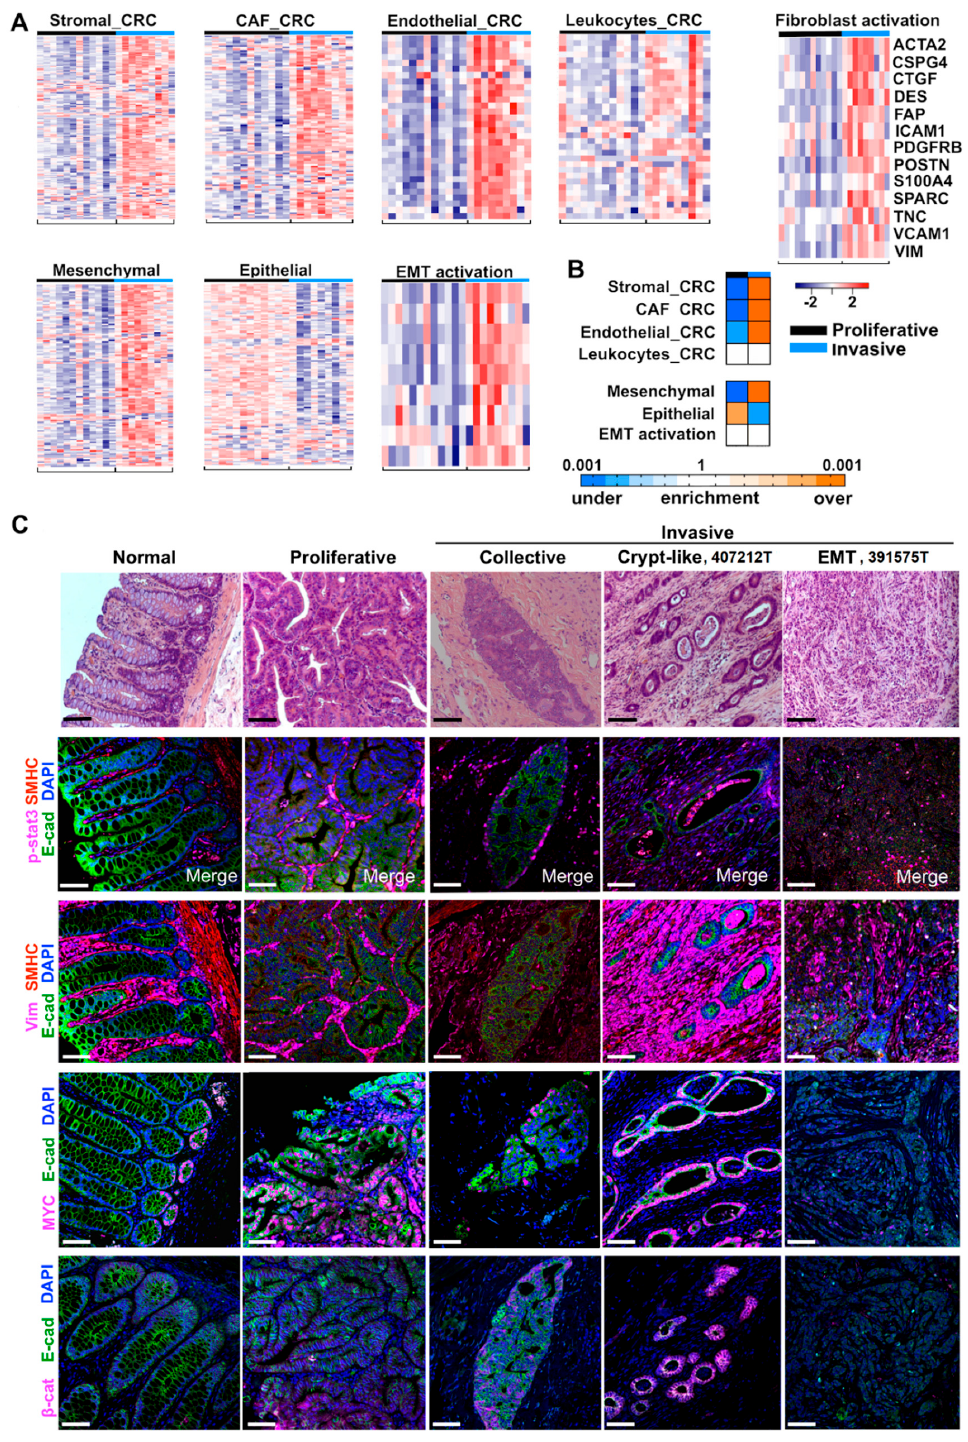
Figure 3. Stromal signatures are activated in invasive tumors and three invasion modes are observed. ( A ) Heatmaps indicate higher expression levels of stromal and EMT signature genes in invasive tumors than in proliferative tumors. Heatmaps are presented as described for Figure 2A. ( B ) Heatmaps of the GSEA p-values of the signatures indicated. ( C ) Representative IHC images of normal colon, proliferative tumor, and tumors of three invasion modes. In crypt-like invasion (407212T), tracks of MYC-positive crypt-like structures are surrounded by dense and multilayers of fibroblasts. β -cat: β -catenin. See also Figure S3, Tables S2 and S3.